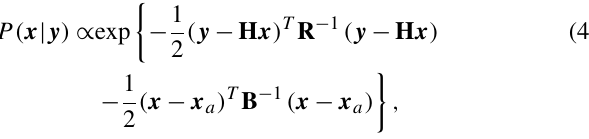
Table 1. Forward model error is estimated by computing STILT footprints for a subset of the meteorological